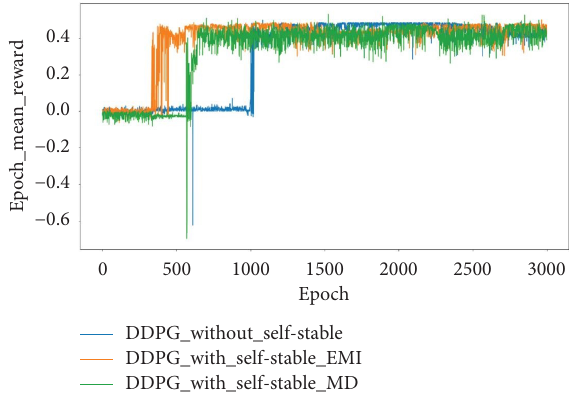
Figure 7: Average reward of agent in the training process.